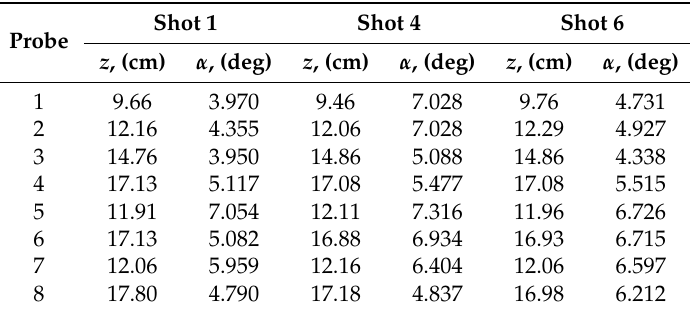
Figure 1. Experimental assembly. Table 1. Axial coordinate and incidence angle α for each of the eight Photon Doppler Velocimetry (PDV) probe